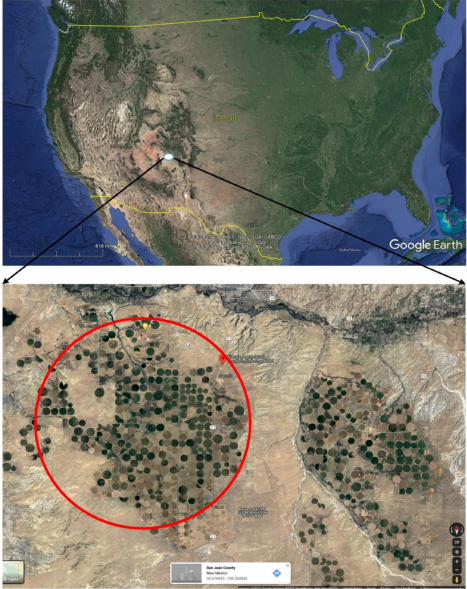
Figure 1. Presentation of the study site in San Juan County, Northwestern New Mexico (white dot on the US map) and the Navajo Agricultural Products Industry Farm. The green circles are the center pivot irrigated fields and the large red circle represents the potato grown area within the rotation cropping system (downloaded from Google earth on 19 December